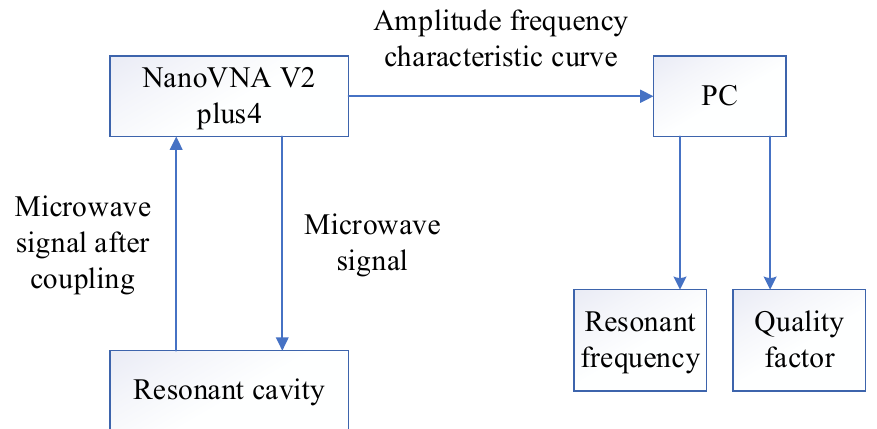
Figure 2. Working principle of experimental platform.